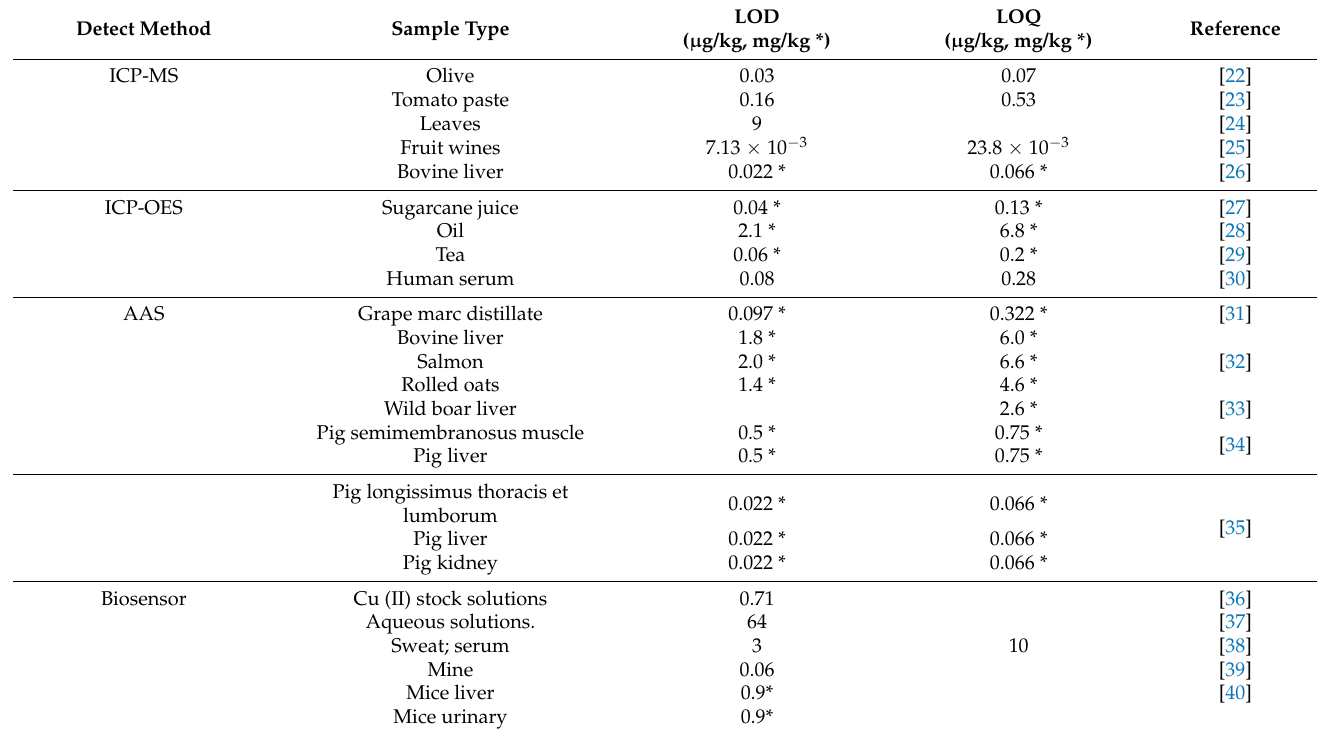
Table 1. Detection method of Cu content in different